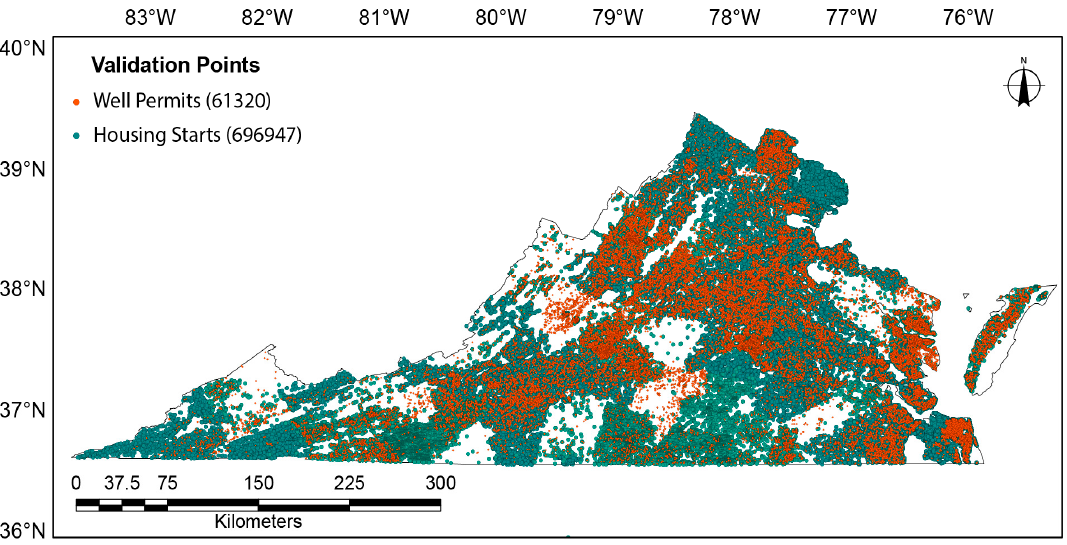
Figure 2. Display of all geocoded points for both datasets from which the validation dataset was sampled.